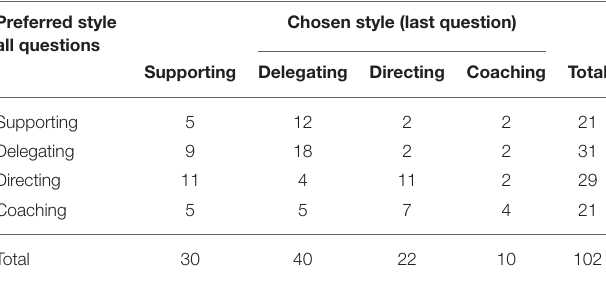
TABLE 7 | Cross tabulation of the style chosen by students as best fitting their needs in the last question of the questionnaire, and the preferred guidance style as deduced from the student’s answers to all questions about behavior aspects of the